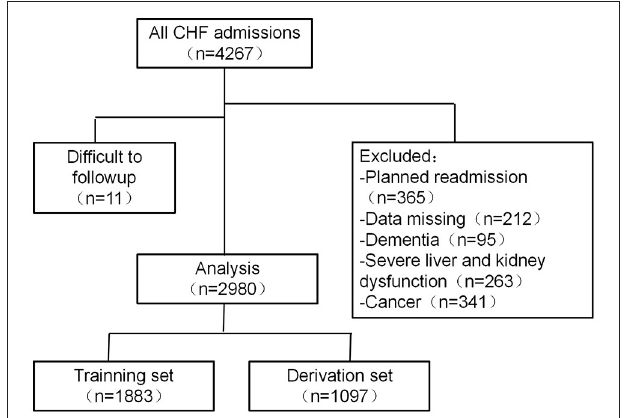
FIGURE 1 | Flowchart of the chronic heart failure prediction